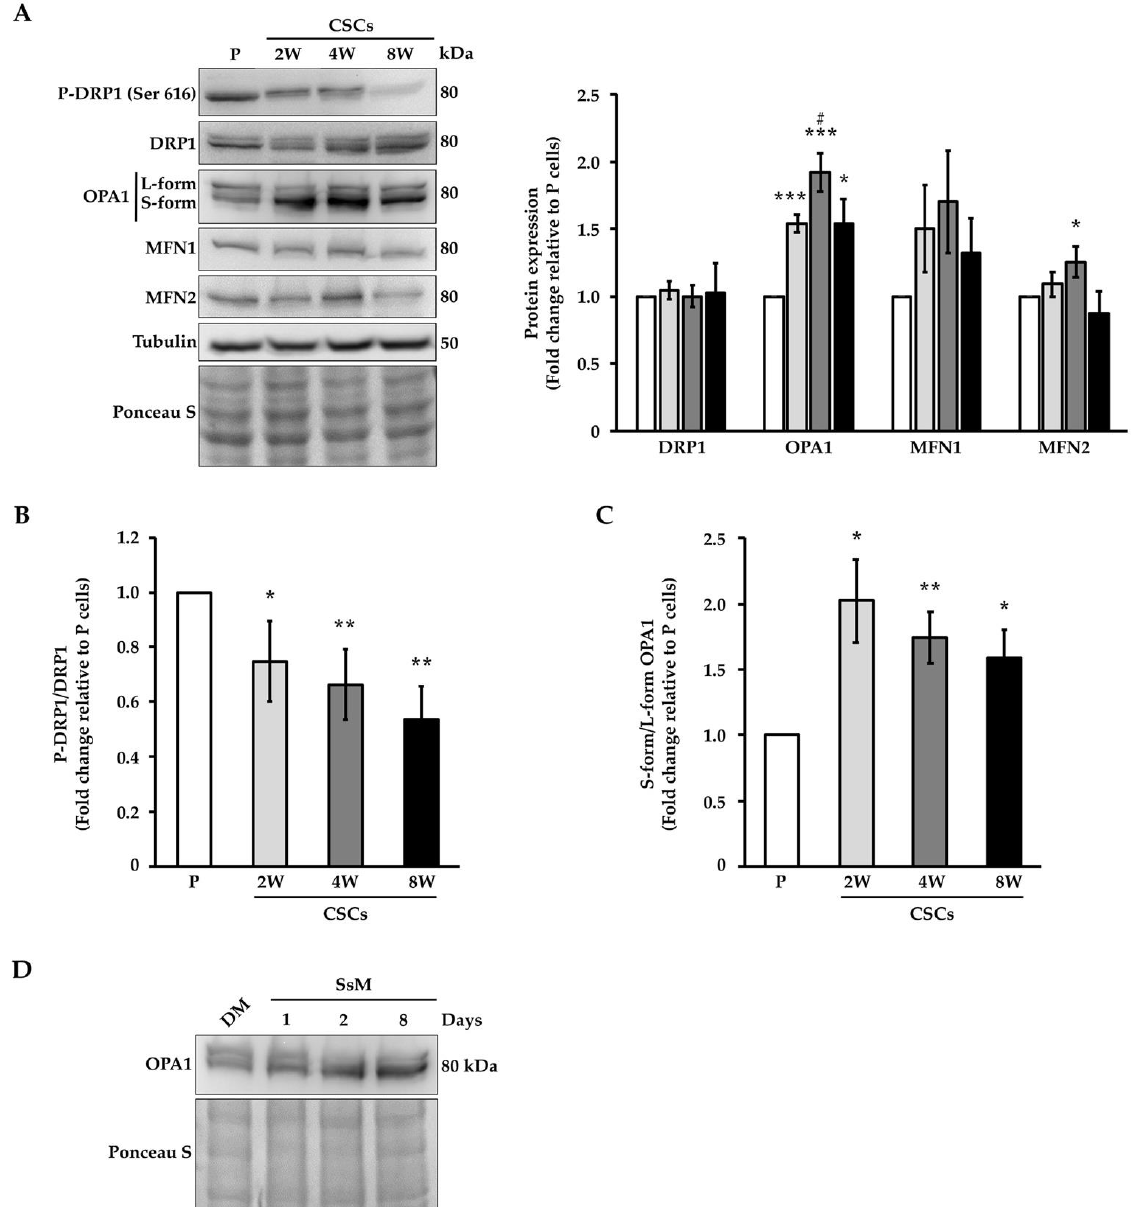
Figure 4. CSC show an increased expression and regulation of fusion markers. ( A ) Left panel, representative immunoblots of the expression of proteins regulating mitochondrial dynamics for parental cells and CSCs; right panel, densitometry analysis average of three different biological samples of the total amount of proteins. Ponceau Stain and tubulin are shown as the loading controls. The ratio of the densitometry analysis of ( B ) phosphorylation of DRP1 (Ser616)/total DRP1 and ( C ) short/long OPA1 isoforms. ( D ) Representative immunoblot of the expression of OPA1 in Panc1 cells grown in differentiated-cell medium (DM) and stem-specific medium (SsM) for 1, 2, and 8 days. Ponceau stain is shown as the loading control. The values are reported as fold change relative to P cells. Histogram legends: white: P cells; light gray: CSCs 2 weeks (2W); dark grey: CSCs 4 weeks (4W); black: CSCs 8 weeks (8W). Bars indicate the mean ± SEM of the indicated samples. Statistical legends: Parental vs. CSCs = * p < 0.05, ** p < 0.01, *** p < 0.001; 2W CSCs vs. CSCs = # p <